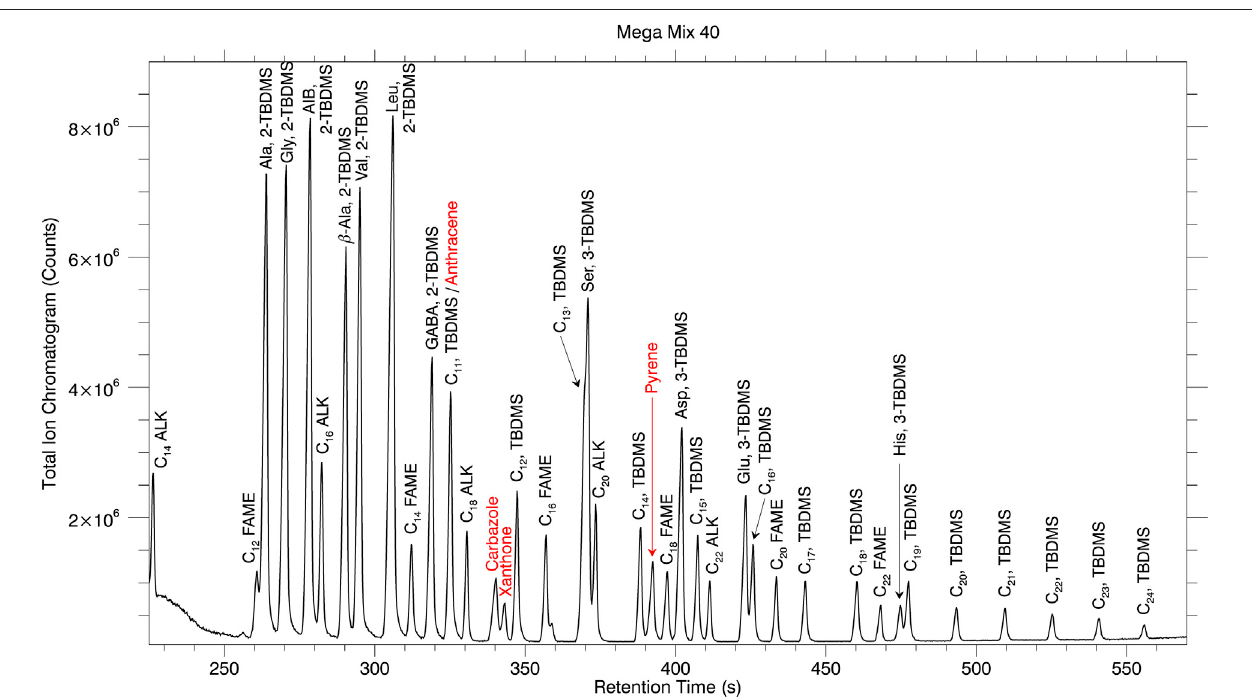
FIGURE 5 | Chromatogram of the Mega Mix 40 mixture. The majority of the compounds are baseline separated. The forward slash between C 11 , TBDMS and anthracene denotes that these peaks overlap under the present chromatographic conditions.